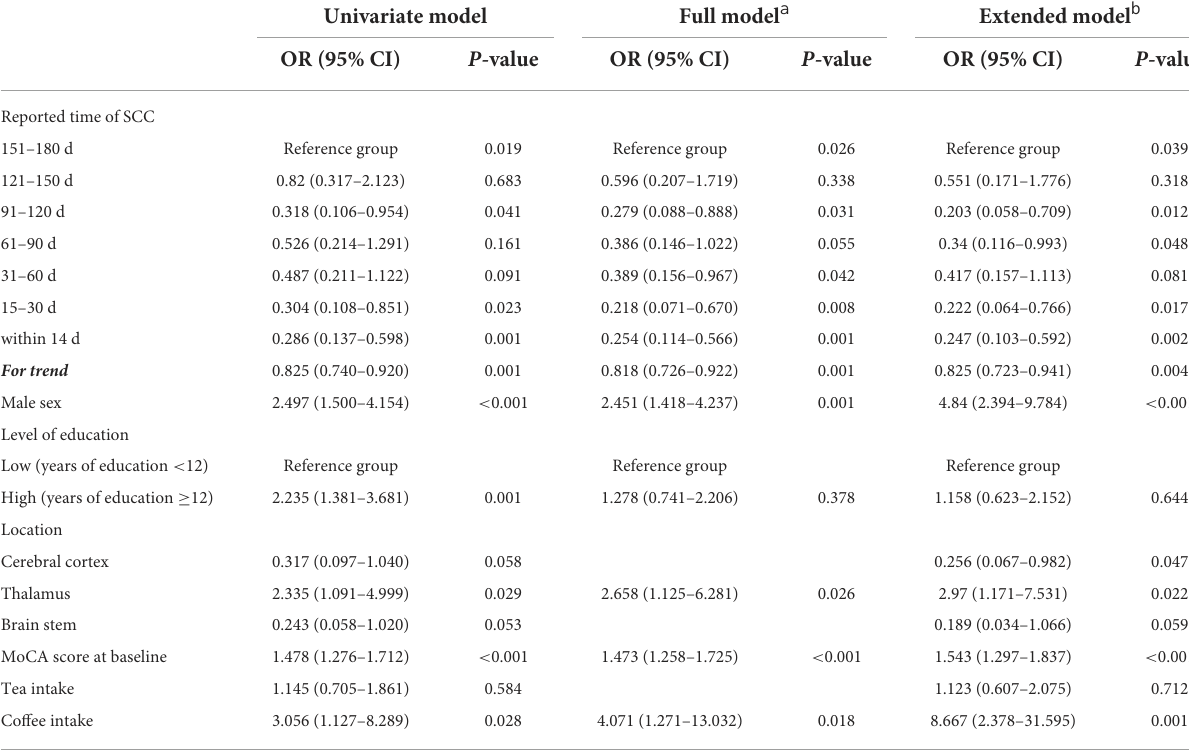
TABLE 3 Factors associated with cognitive recovery in patients with post-stroke